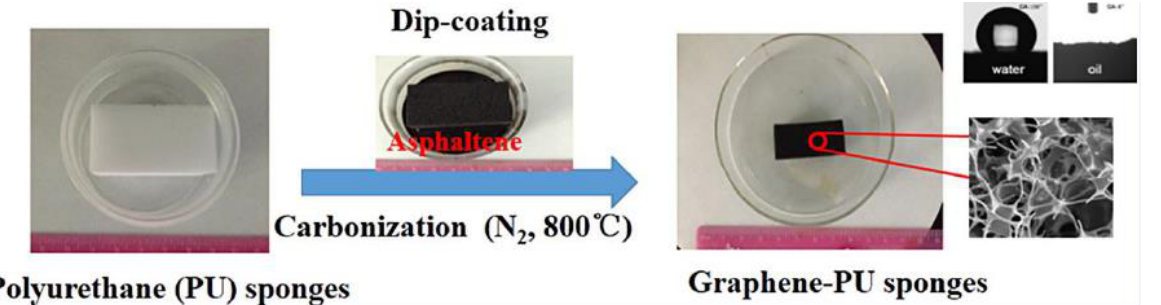
Figure 23. High-quality asphaltene-based graphene – polyurethane sponges (GPU) as absorbent (reprinted with permission from Ref. [86]).